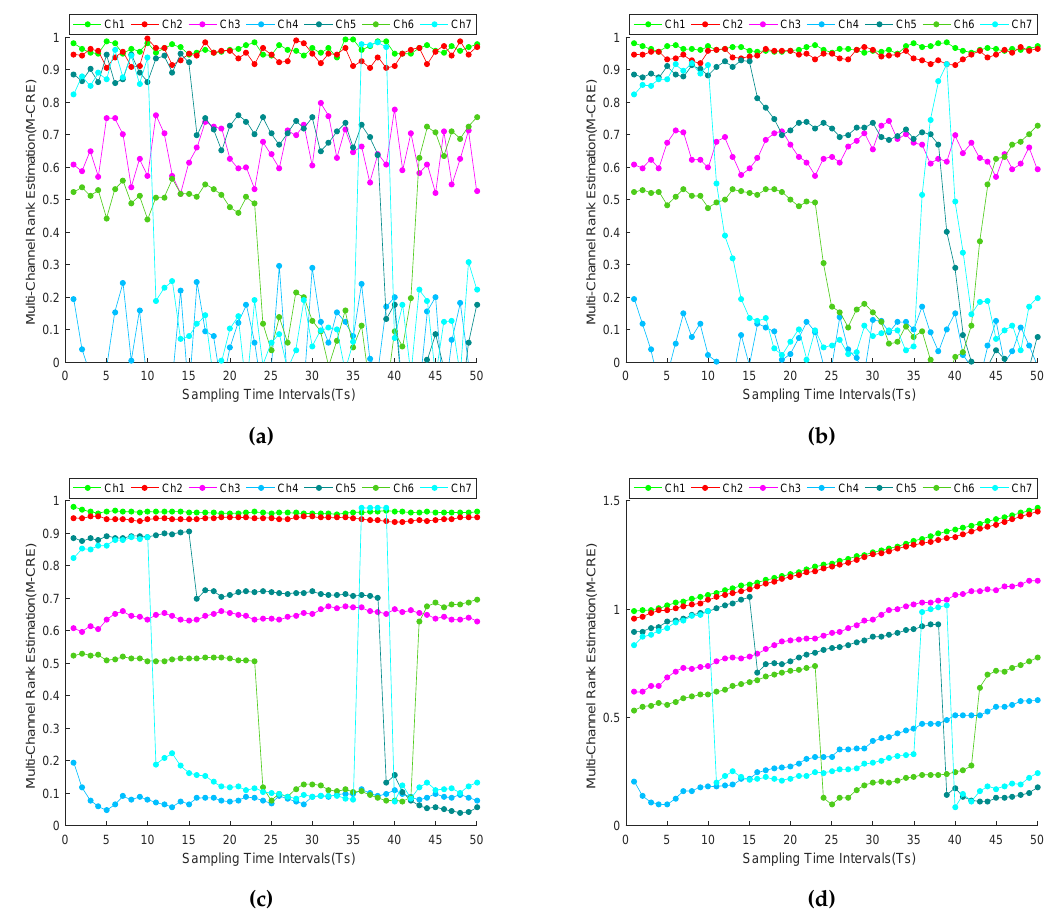
Figure 7. Channel quality (and stability) assessment results. ( a ) results for NEC; ( b ) results for NEWMAC; ( c ) results for NEAMCBTC; ( d ) results for Ext-NEAMCBTC (with